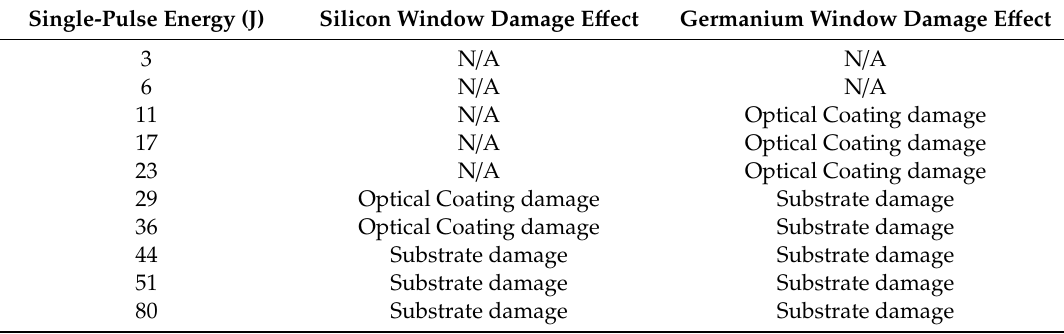
Table 6. Experimental results of the long-pulse